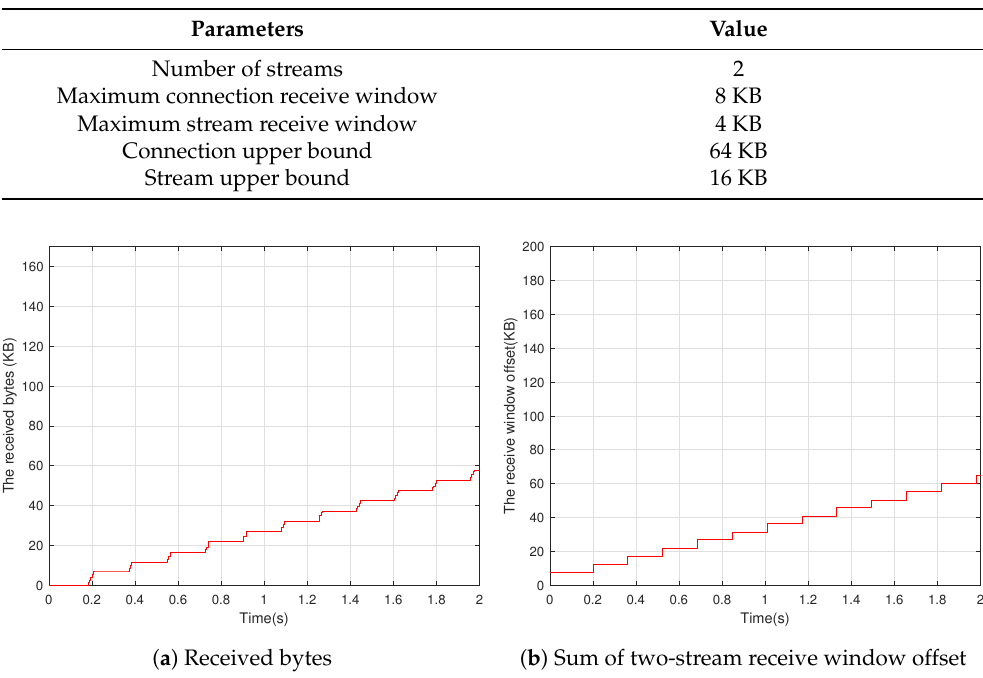
Table 1. Parameter setting for a two-stream connection.